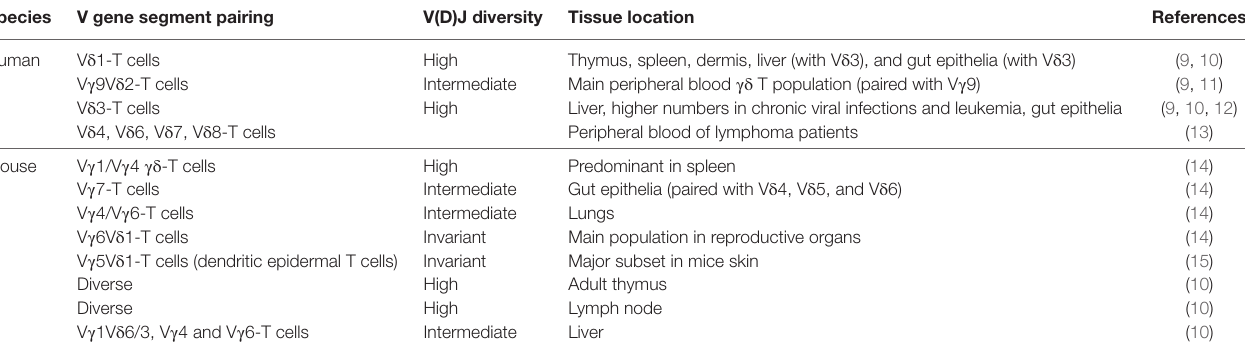
TABLe 1 | γδ T cell subsets and tissue locations in human and mouse.